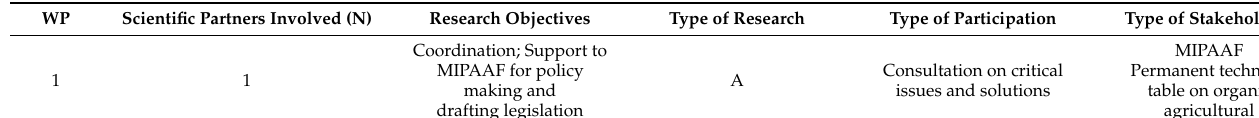
table on organic